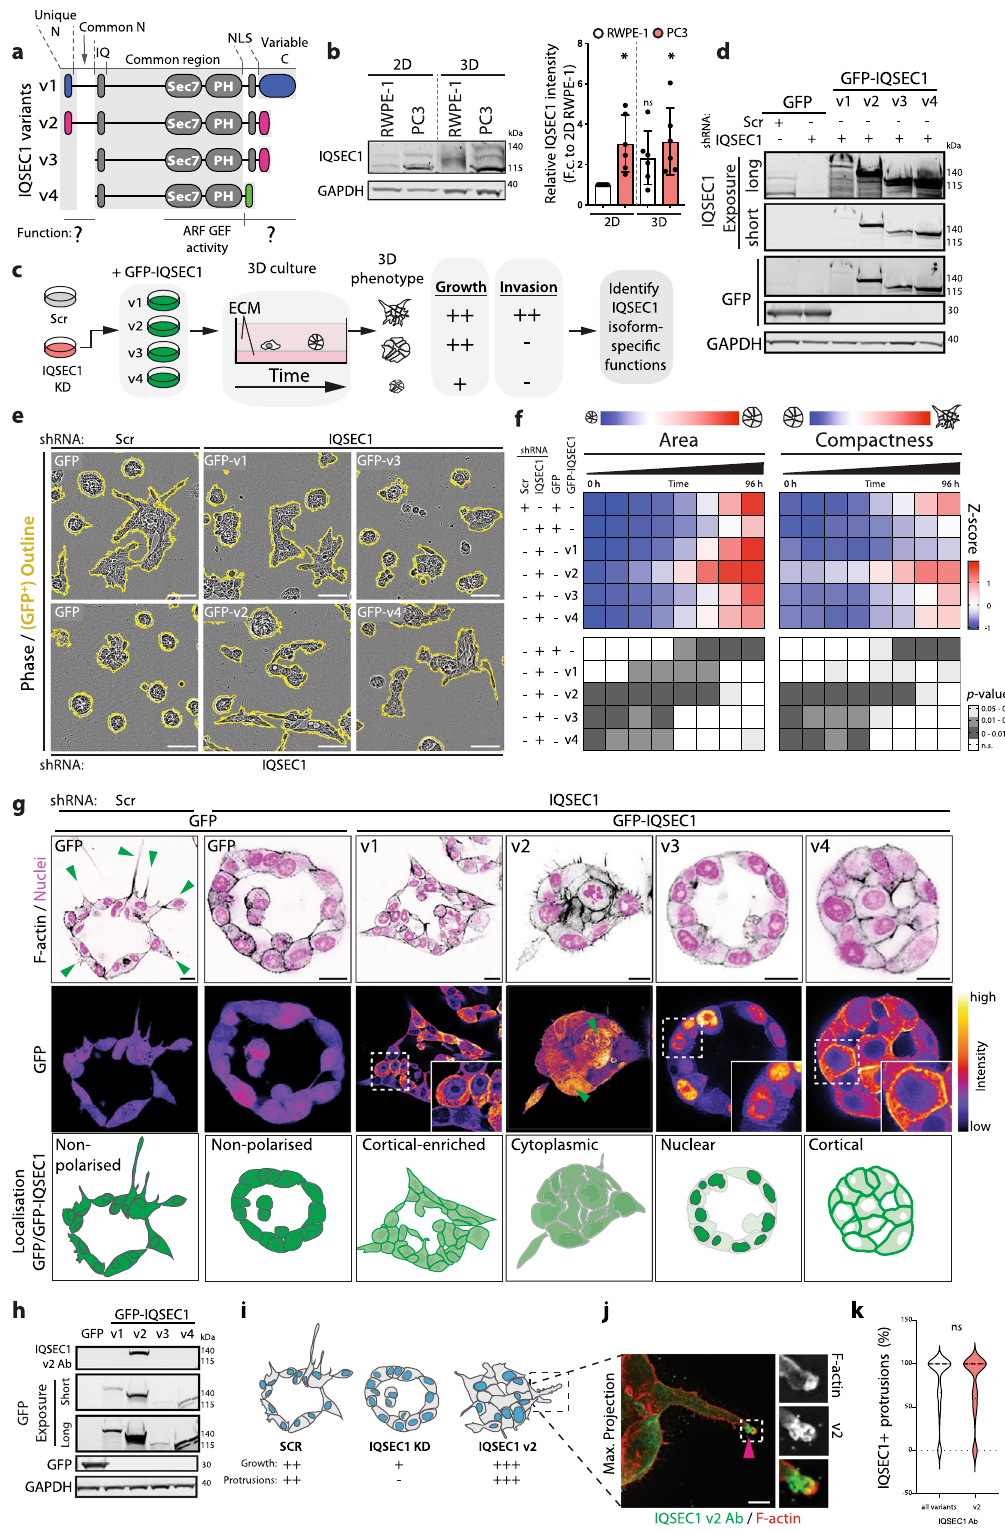
To identify the location of active ARF we expressed a sensor that detects GTP-loaded ARF proteins (GGA1 NGAT domain 36 ) (Fig. 3i). GGA1 NGAT-TagRFP-T colocalized with ARF6 most notably in the tips of protrusions (Fig. 3j, green arrowheads), and with ARF5 in puncta in the body of the protrusion (white arrowheads) and the acinus body itself (white